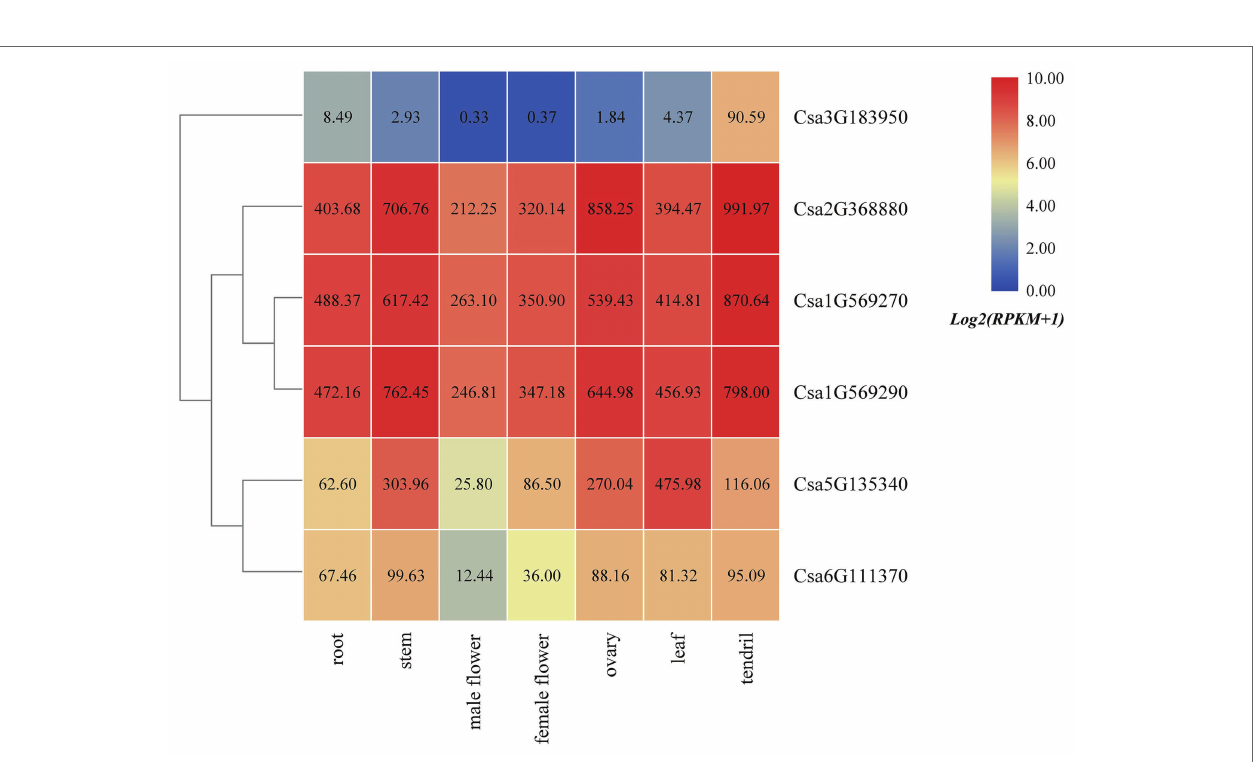
FIGURE 4 | Distribution of cis -elements in the promoters of cucumber HSP90 genes. (A) The number of various cis -elements in the promoters of each cucumber HSP90 gene. (B) The relative proportions of different cis -elements in the promoters of cucumber HSP90 genes are indicated by the pie chart. Cis -elements sharing identical or similar functions are represented by the same color.